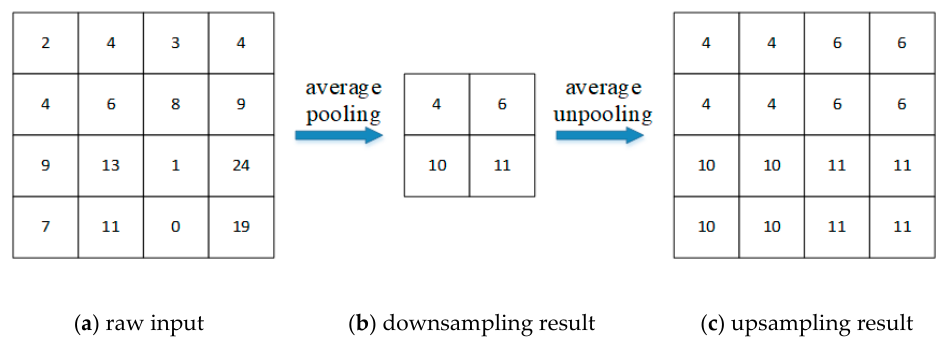
Figure 7. OctConv sampling principle.